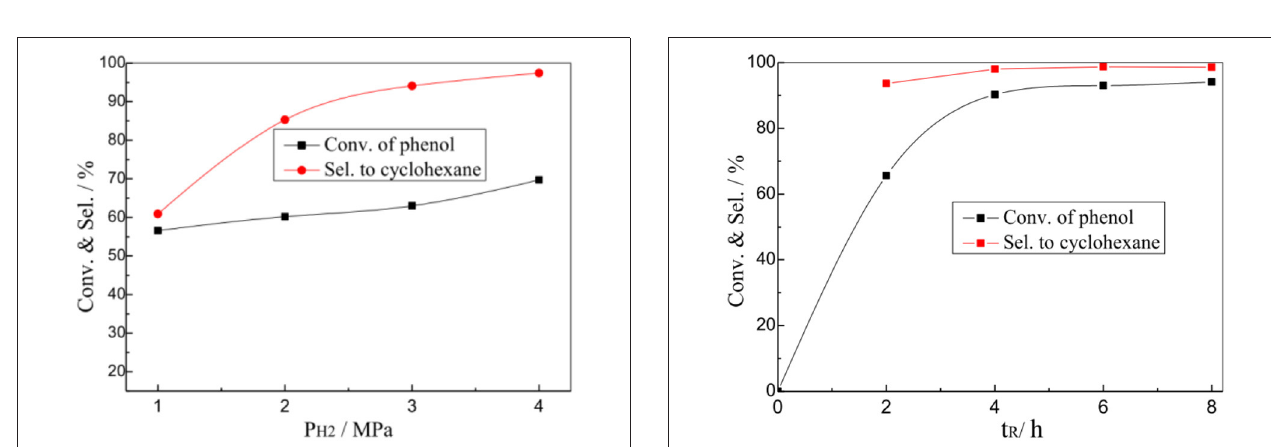
FIGURE 6 | Effect of P H2 on the HDO of phenol over 1%Pt/SBA-Pr. Reaction conditions: T R , 200 ◦ C, 800 rpm; t R , 4h, 0.0250mol PhOH in 50.0mL CH 2 Cl 2 , 0.4878g 1%Pt/SBA-Pr (n Pt :n PhOH ) = 1:1000).